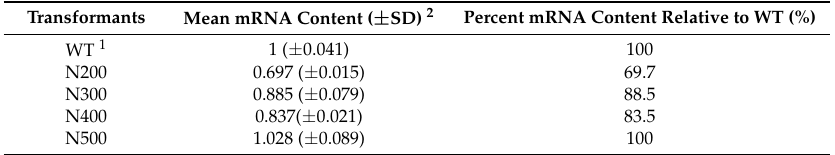
Table 2. Comparative content of NADHox mRNA in the transformants synthesizing dsRNA from 200 to 500 bp with respect to the WT strain, as measured by RT-qPCR.